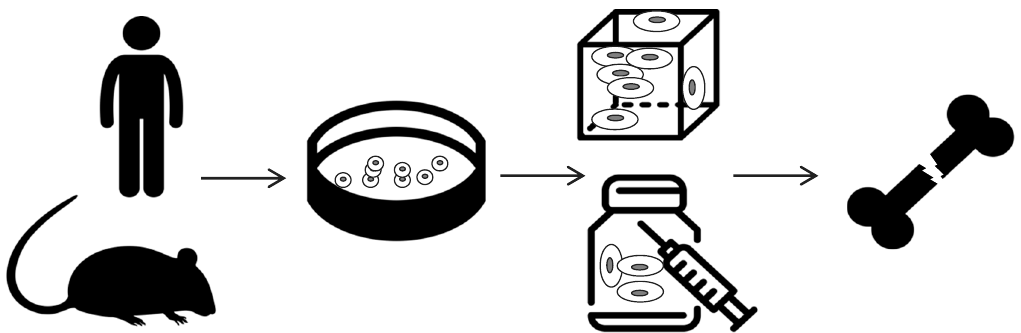
Figure 1. Schematic representation of the main components of the bone tissue engineering. In this review we will focus on the natural and synthetic polymeric scaffolds.